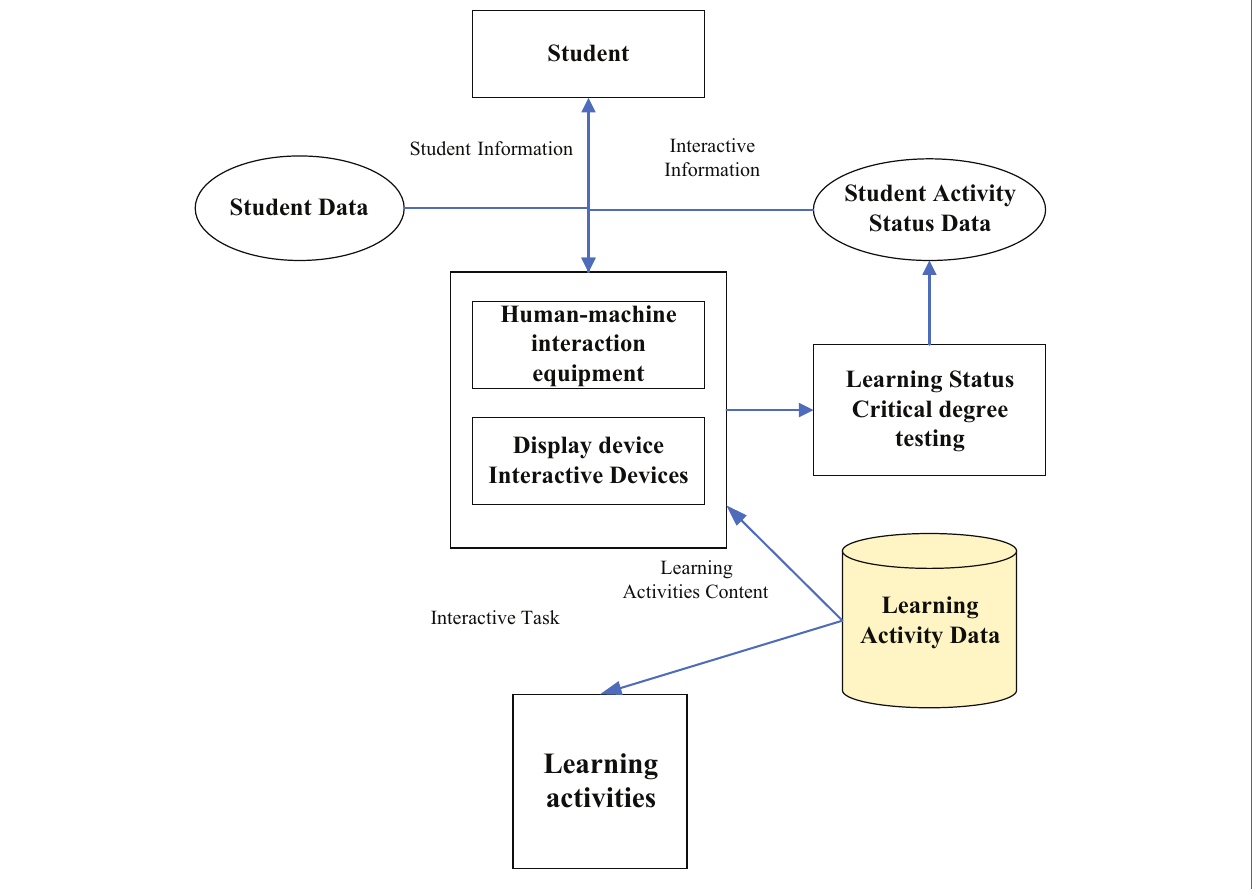
FIGURE 4 | Structure of HCI learning